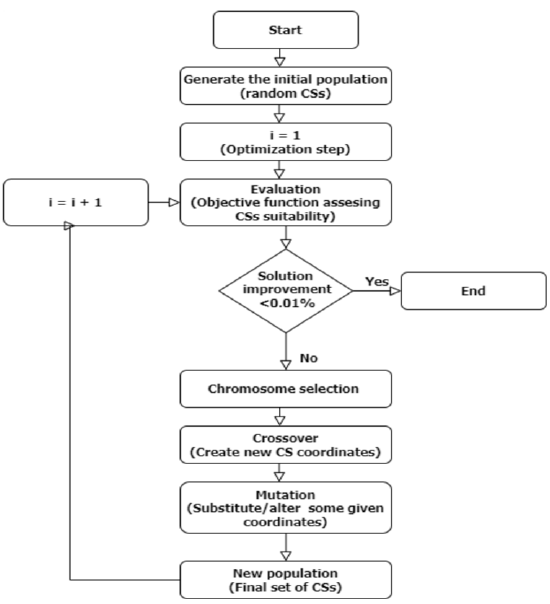
Figure 1. Genetic Algorithm fl owchart.